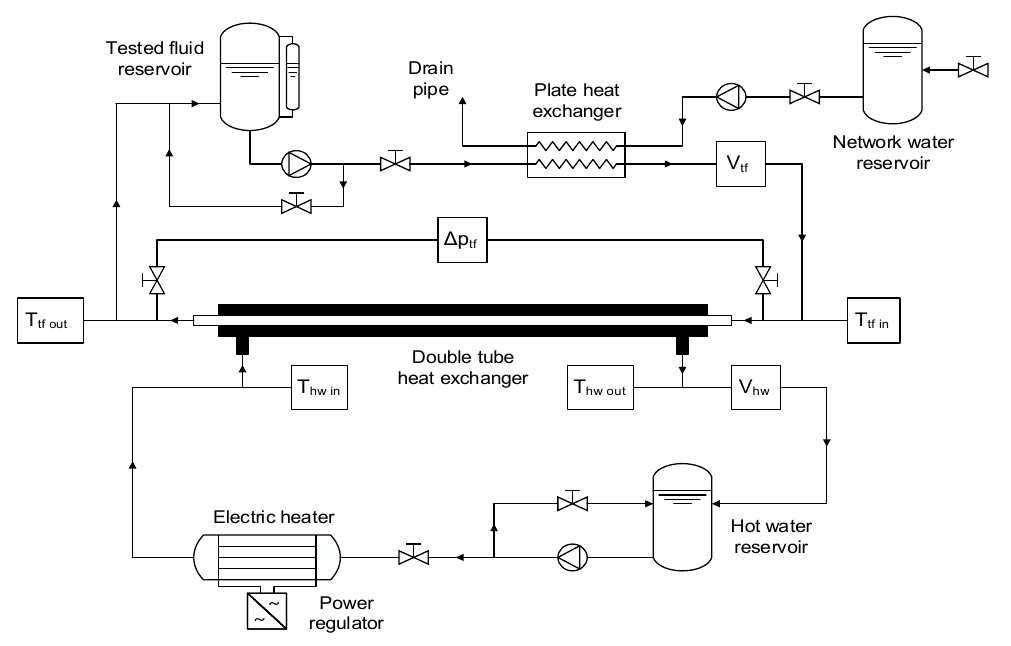
Figure 7. Layout of the experimental setup for the determination of heat transfer coefficients and pressure drop.